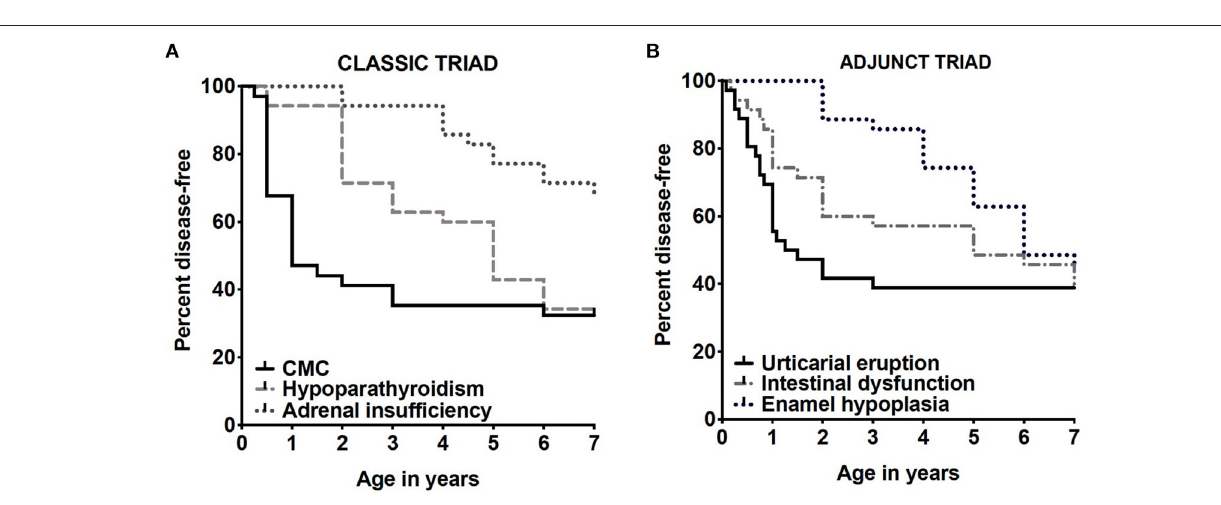
FIGURE 2 | Shown are Kaplan-Meier curves demonstrating prevalence by age of classic triad manifestations (A) and adjunct triad (B) appearing by age 7 years, the average age of diagnosis by classic diagnostic criteria among the first 35 patients with APECED. These images are derived from Ferre et al.